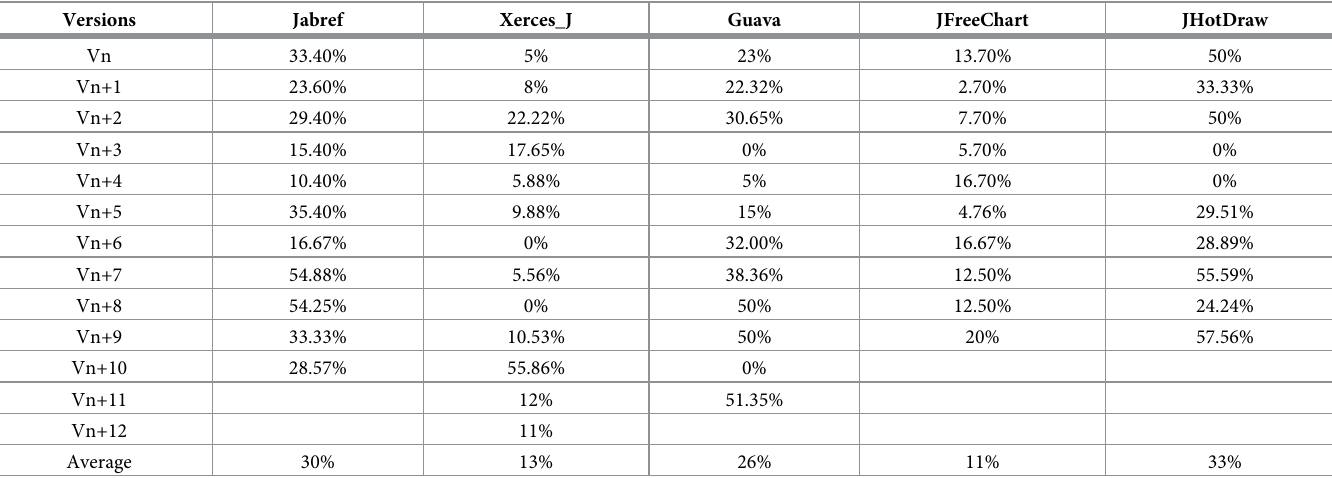
Table 4. Removed clones in versions of five Java